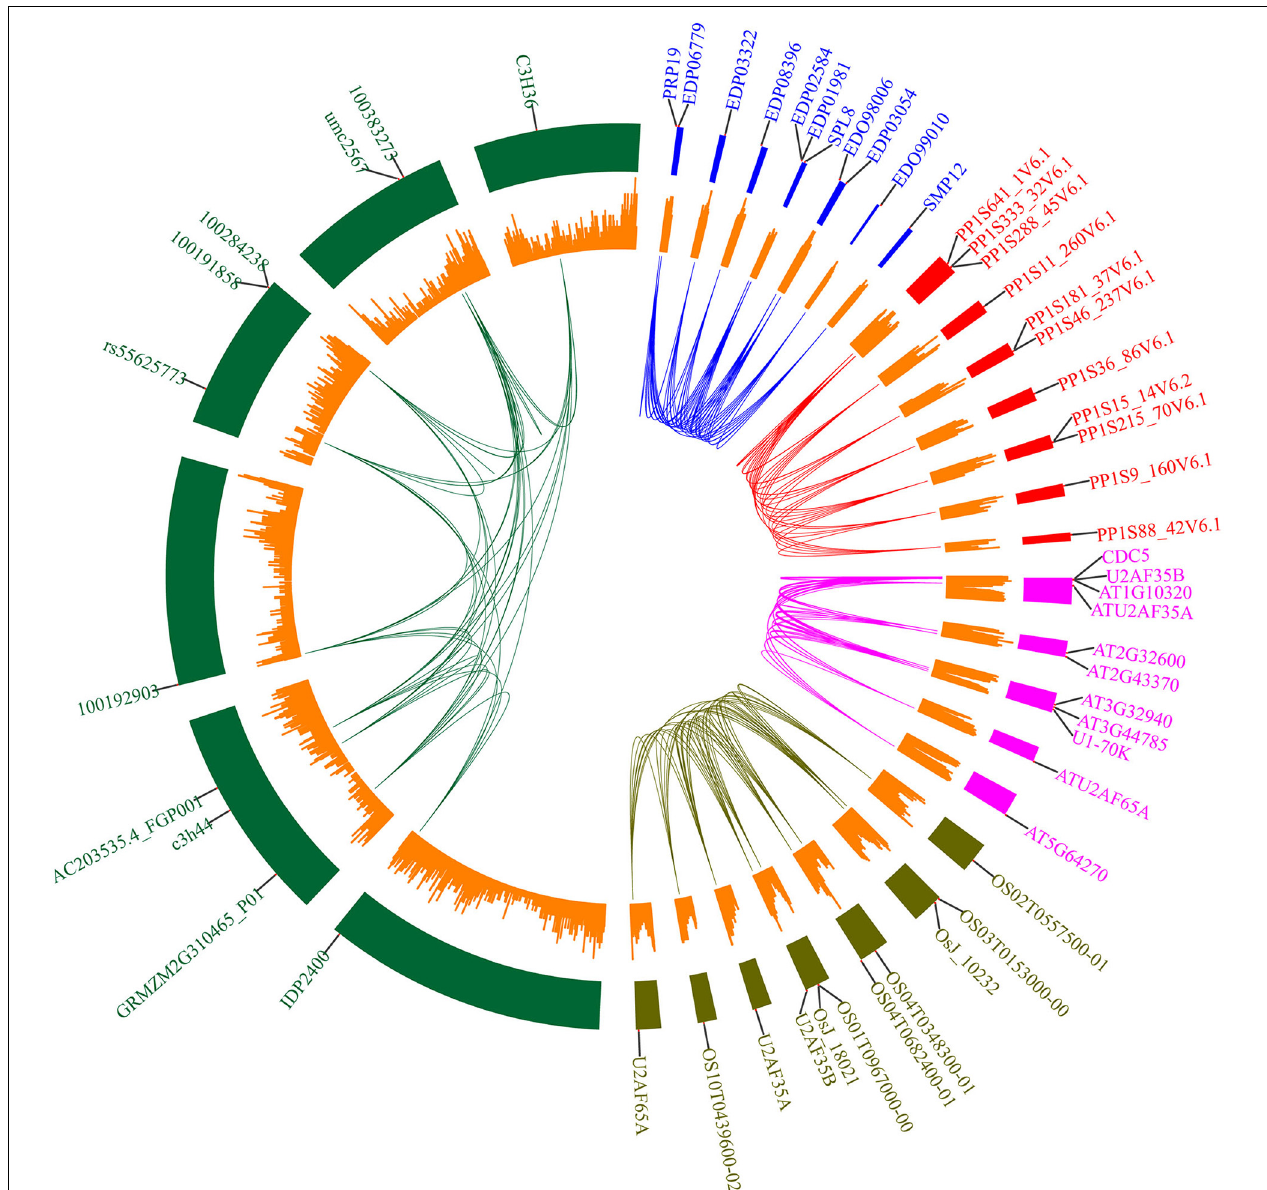
FIGURE 6 | Protein interacting-partners of Arabidopsis thaliana, Oryza sativa, Zea mays, Physcomitrella patens, and Chlamydomonas reinhardtii U2AF65A proteins. Protein interaction networks within species were connected by lines of corresponding colors. Red represents Physcomitrella patens , green represents Zea mays , blue represents Chlamydomonas reinhardtii, pink represents Arabidopsis thaliana, and brown represents Oryza sativa. The small orange rectangle represents the number of genes contained in the chromosome region. The outer label represents the genes encoding the interacting